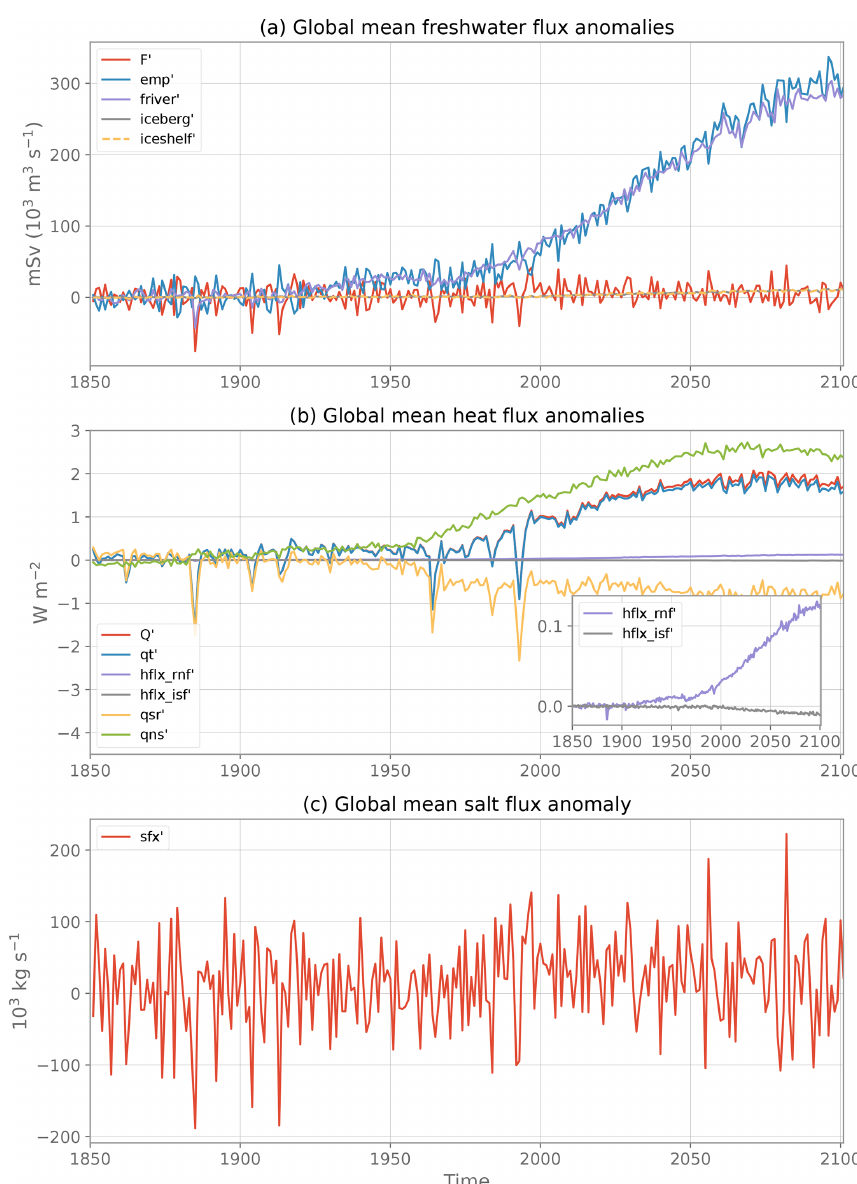
Figure 8. Evolution of the globally averaged, annual mean (a) freshwater flux, (b) heat flux and (c) salt flux anomalies as computed from the IPSL-CM6A-LR ensemble mean anomalies relative to 1850–1899. See Table 1 for the signification of each flux